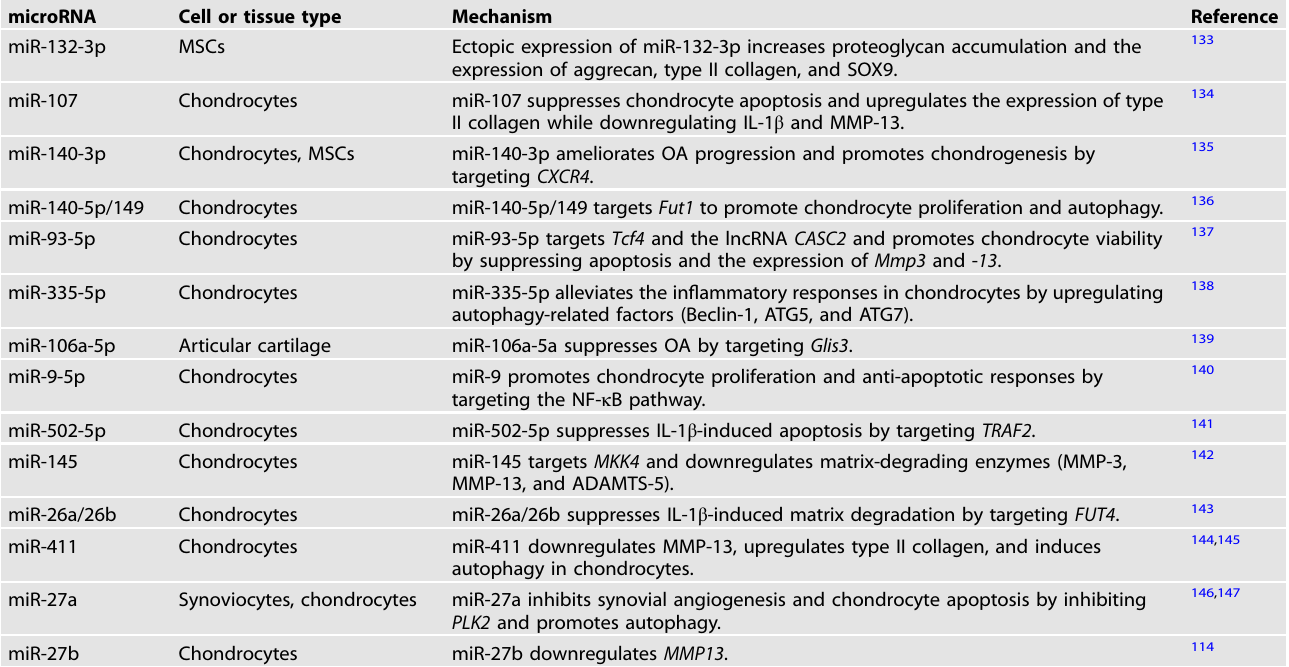
MSCs mesenchymal stem